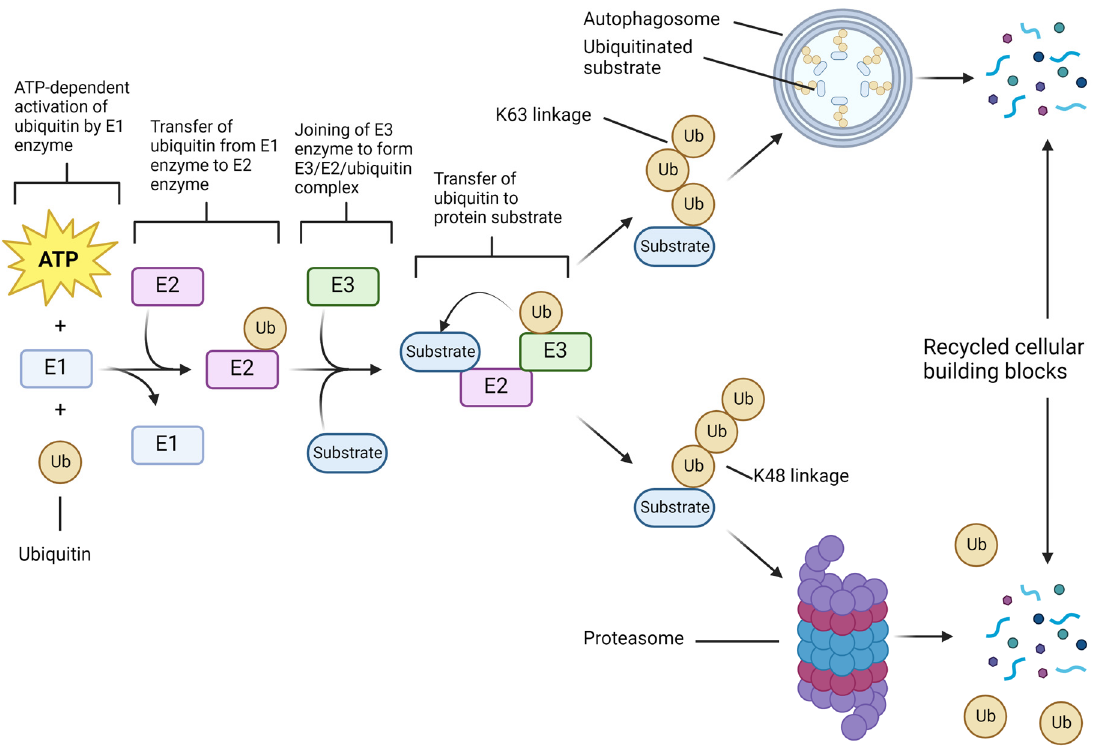
Figure 1. Ubiquitin plays an essential role in proteasomal and autophagic degradation of proteins in the GBM cells. Ubiquitin forms the basis of both autophagic and proteasomal signaling. Ubiqui- tination begins with the ATP-dependent activation of ubiquitin by an E1 enzyme. The activated ubiquitin is then passed to an E2 enzyme, which subsequently serves as a link between the target substrate and the E3 ubiquitin ligase. The E3 ligase then catalyzes the transfer of ubiquitin from the E2 enzyme to the substrate. Substrates may be mono-ubiquitinated, multi-mono-ubiquitinated, or have a ubiquitin chain attached; ubiquitin chains can be linked in a variety of ways including mixed and branched chains. Different configurations of ubiquitin linkages determine the pathway the substrate will continue down; this is known as the ubiquitin code. K48 linked chains tend to direct the substrate to proteasomal degradation, while K63 chains mark the substrate for autophagic degradation. Many other types of linkages are possible but are not shown here. Ub,